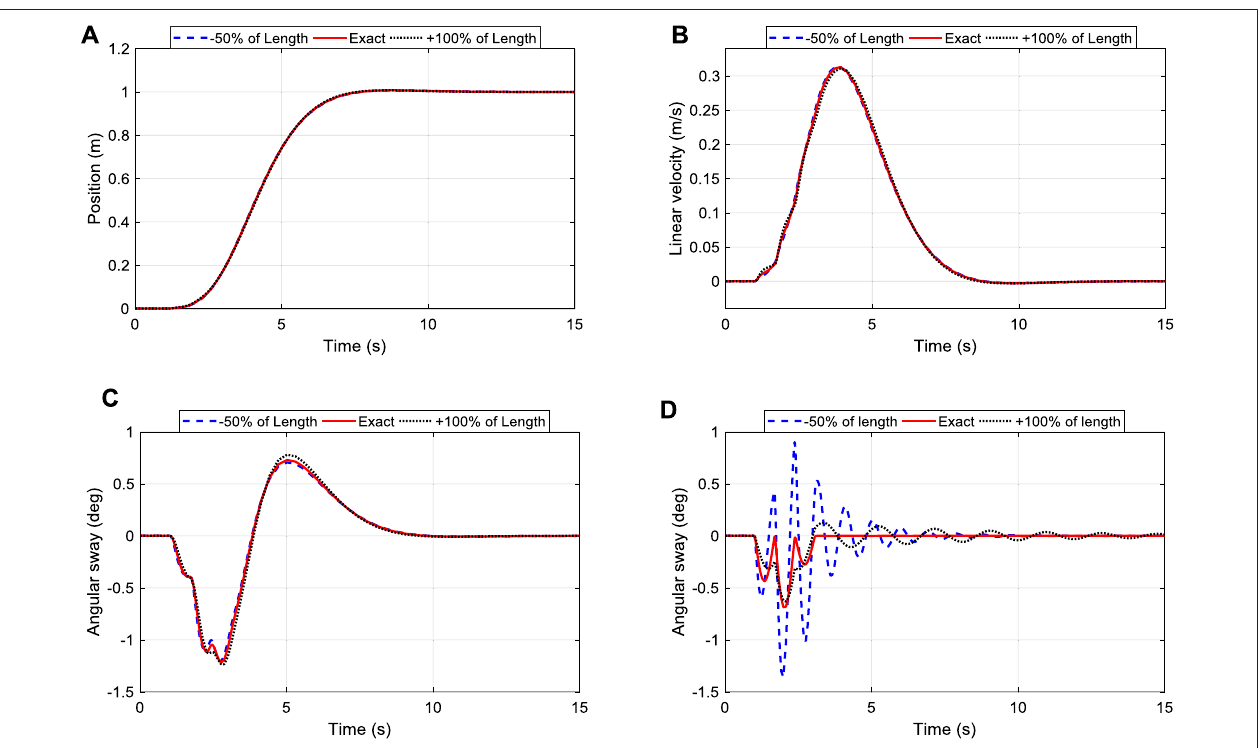
FIGURE11| RobustnessofiTDC+PPC and TDC tochangesofarm length: (A) Position Tracking; (B) Linear Velocity oftheroller; (C) Oscillation control ofthe arm; (D) Oscillation control of TDC.